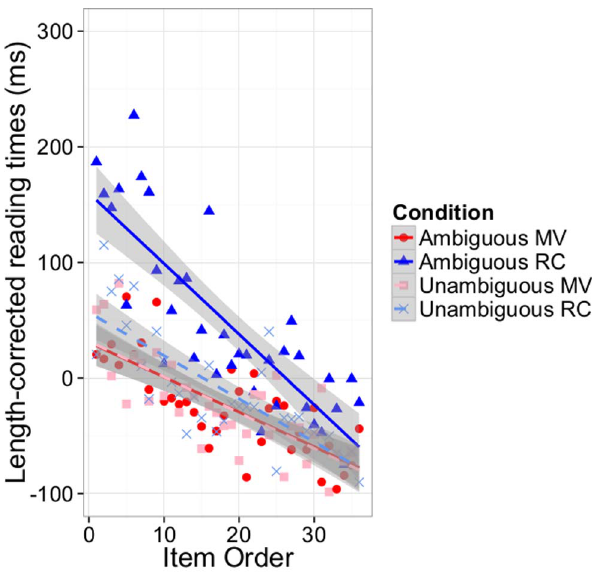
Figure 5. Adaptation effect for Experiment 1. Change in length- corrected RTs plotted against item order, for ambiguous (dark lines) and unambiguous (light lines) MVs (red) and RCs (blue). Gray shaded regions correspond to 95% confidence intervals on the